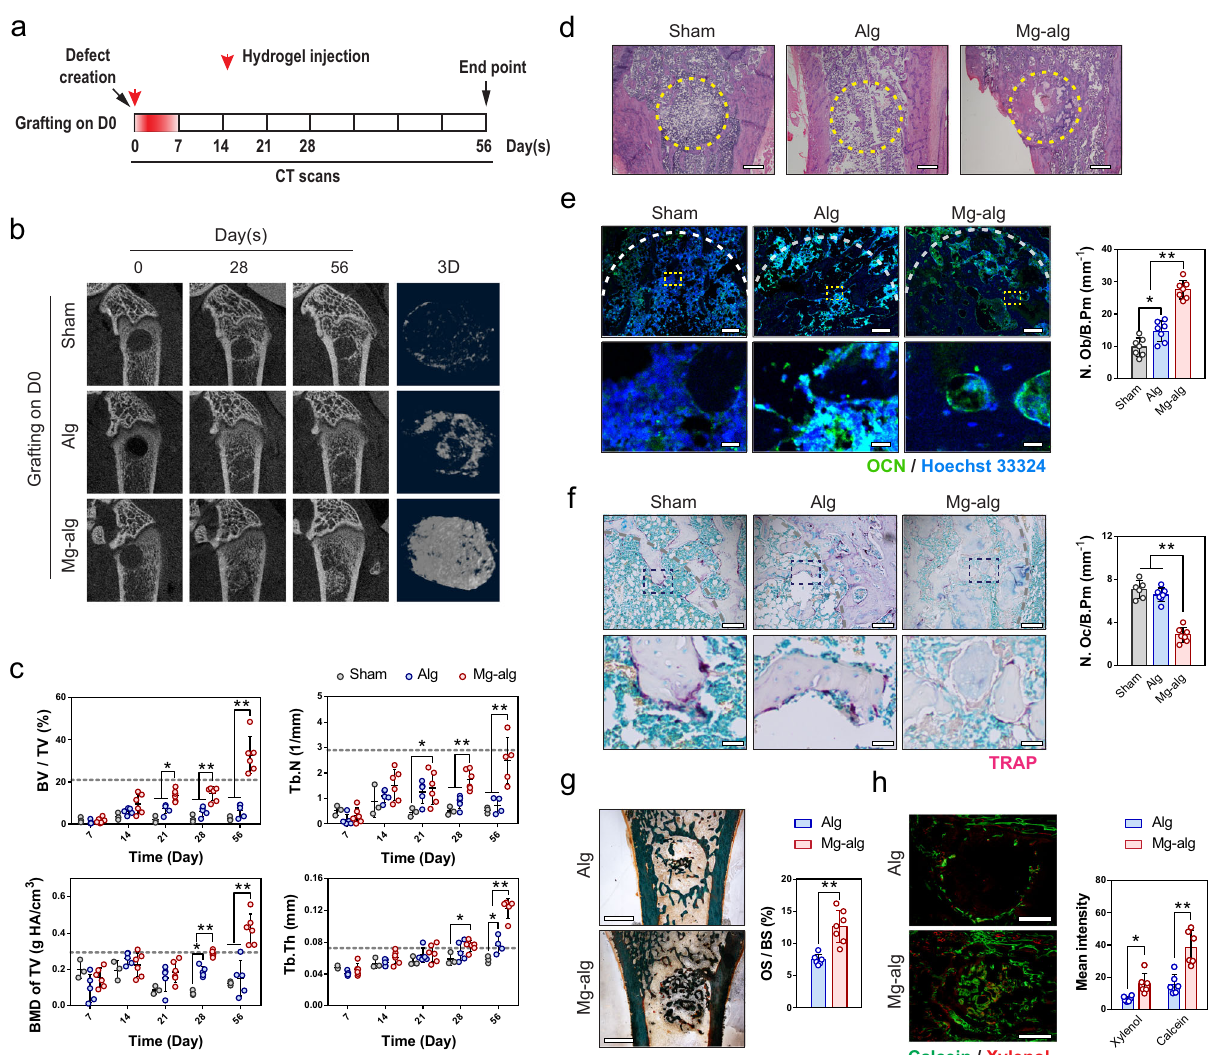
Fig. 1 Mg 2 + releasing alginate promoted bone healing of defects in the rat femur. a Mg 2 + -crosslinked alginate was injected into the femur defect in rats right after the injury, hence the release of Mg 2 + was limited to the fi rst week of the injury. b Representative micro-CT images and reconstructed 3D images of the defects in rat femora without grafting (Sham, n = 3), grafted with pure alginate (Alg, n = 5) or Mg 2 + releasing alginate (Mg-Alg, n = 6). c Corresponding measurements of trabecular bone fraction (BV/TV), trabecular number (Tb.N), bone mineral density (BMD of TV), and trabecular thickness (Tb.Th) showing the healing process of rat femoral defects. Sham, n = 3; Alg, n = 5; Mg-alg, n = 6. The dashed line shows the mean value of each bone parameter at the defect area before the operation. d Representative H&E staining images of the grafted defects in the rat femora, scale bars = 500 µ m. e Representative immuno fl uorescent images and quanti fi cation showing the presence of osteoblasts (N.Ob/B.Pm, n = 6) in the grafted defects in the rat femora on day 56. Lower images (scale bars = 50 µ m) are high-resolution versions of the boxed regions in the upper images (scale bars = 500 µ m). f Representative TRAP staining images showing the presence of osteoclasts in the grafted defects in the rat femora, and histomorphological analysis of osteoclast numbers (N.Oc/B.Pm, n = 6) in the defects of femora on day 56. Lower images (scale bars = 40 µ m) are high- resolution versions of the boxed regions in the upper images (scale bars = 200 µ m). g Representative Goldner ’ s trichrome staining of the grafted defects on day 56, scale bars = 1 mm, and quantitative analysis of osteoid surface per bone surface (OS/BS, n = 6) in the grafted femoral defects. h Representative images of calcein/xylenol labeling for bone regeneration in the rat femoral defects grafted with alginate or Mg 2 + releasing alginate, scale bars = 1 mm, and quantitative analysis of fl uorescence intensity of calcein/xylenol ( n = 6). Data are mean ± s.d. n.s. P > 0.05, * P < 0.05, ** P < 0.01 by two-way ANOVA with Tukey ’ s post hoc test ( c ), one-way ANOVA with Tukey ’ s post hoc test ( e , f ), or Student ’ s T -test ( g , h